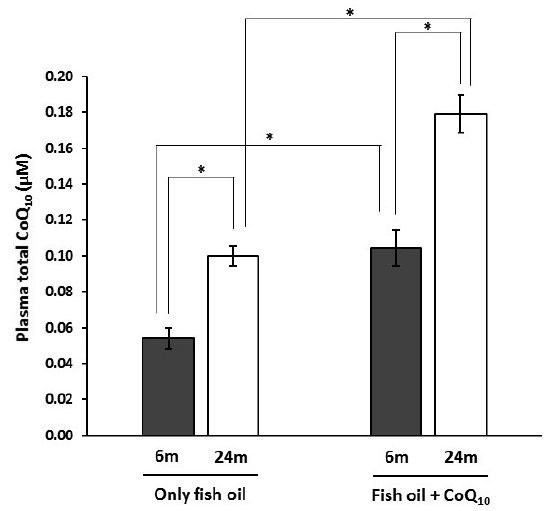
Figure 1. Effects of supplementation with coenzyme Q 10 (CoQ 10 ) on plasma total CoQ 10 levels in 6- and 24-month-old (m) rats fed fish oil as dietary fat. Results are expressed as mean ± standard error of mean of six animals. * Statistically significant differences ( p < 0.05) determined by the Student’s t ‐ test.